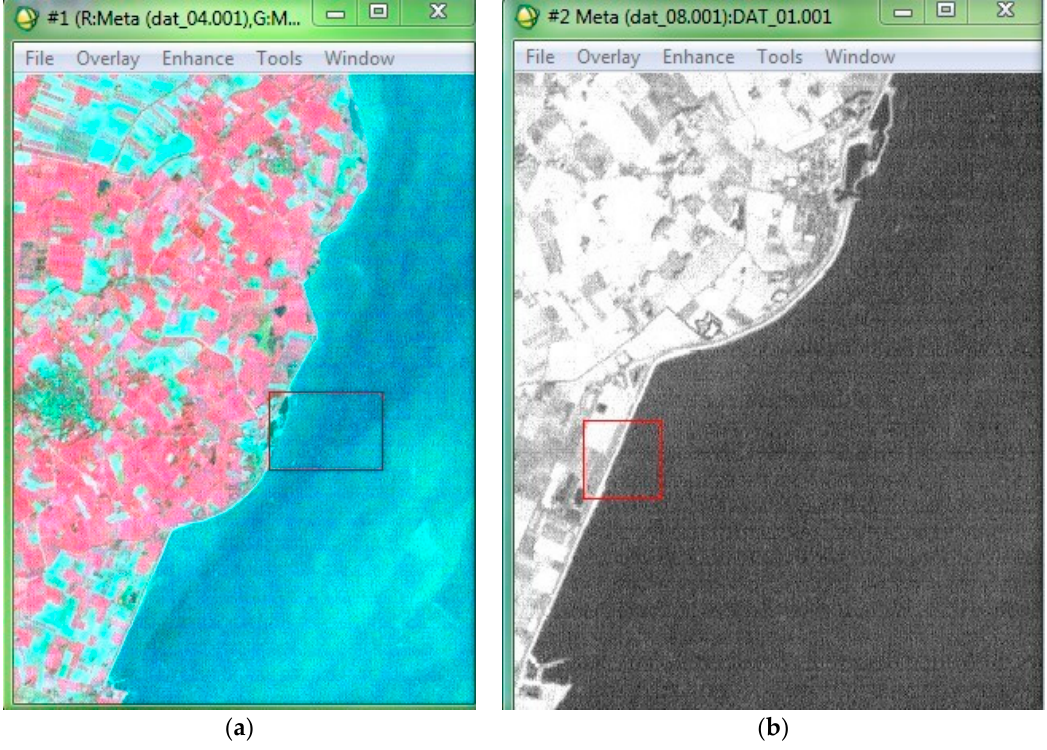
Figure 1. ( a ) Raster image with a resolution of 30 m; ( b ) raster image with resolution of 15 m.